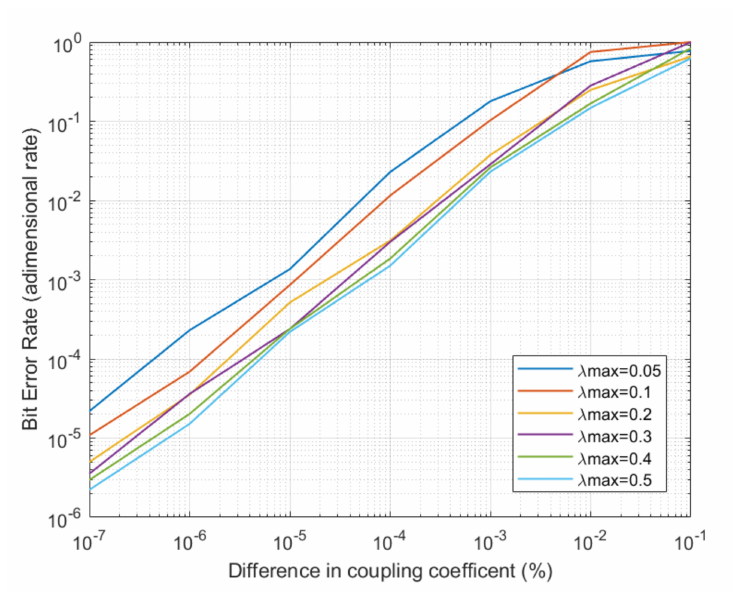
Figure 9. Evolution of BER for di ff erent system configurations.